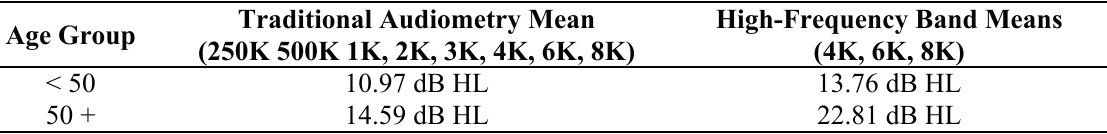
Table 2. Traditional audiometric frequency means by age and